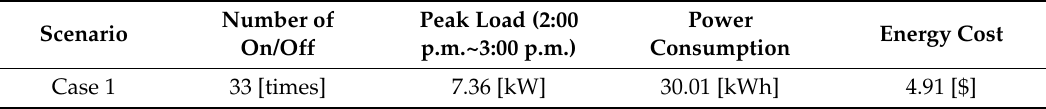
Table 4. Summary of Case 1 simulation